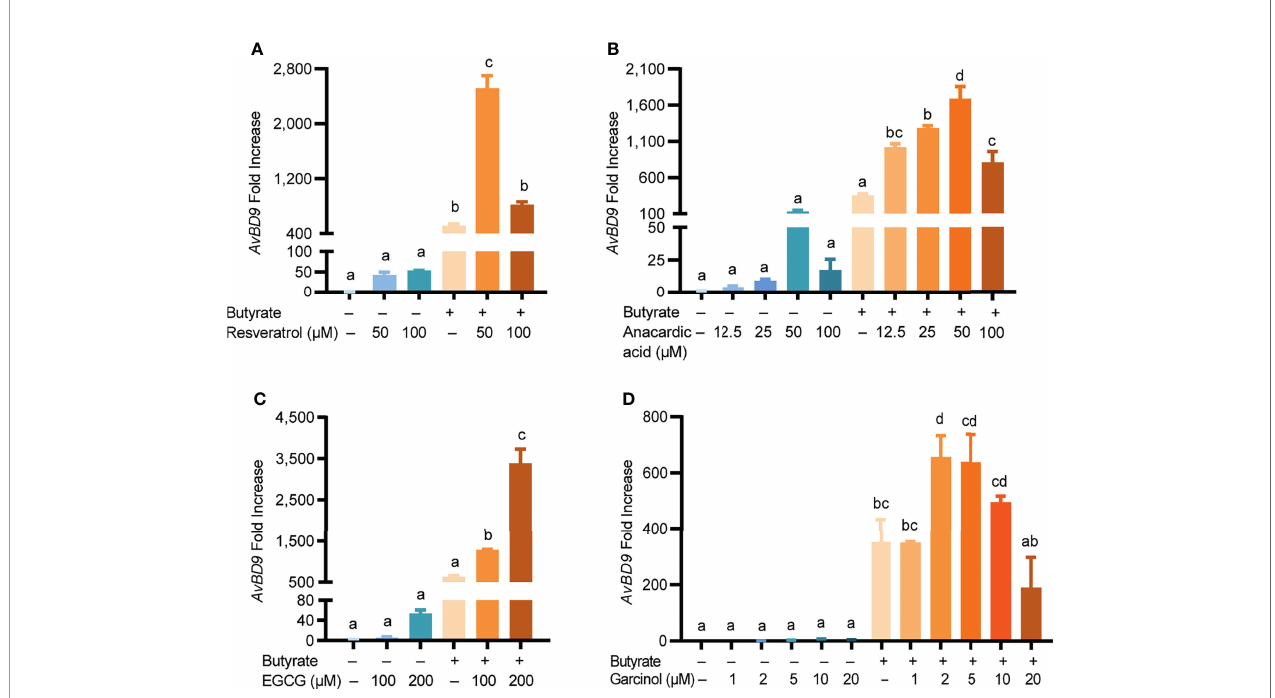
FIGURE 5 | Induction of AvBD9 by natural COX-2 inhibitors and butyrate. Chicken PBMCs were treated in duplicate with indicated concentrations of resveratrol (A) , anacardic acid (B) , epigallocatechin gallate (EGCG) (C) , or garcinol (D) , in the presence or absence of 2 mM butyrate for 24 h, followed by AvBD9 expression analysis. Results are presented as means ± SEM of 2 – 3 independent experiments. The bars not sharing common superscript letters are signi fi cantly different ( P < 0.05) as determined by one-way ANOVA and post hoc Tukey ’ s